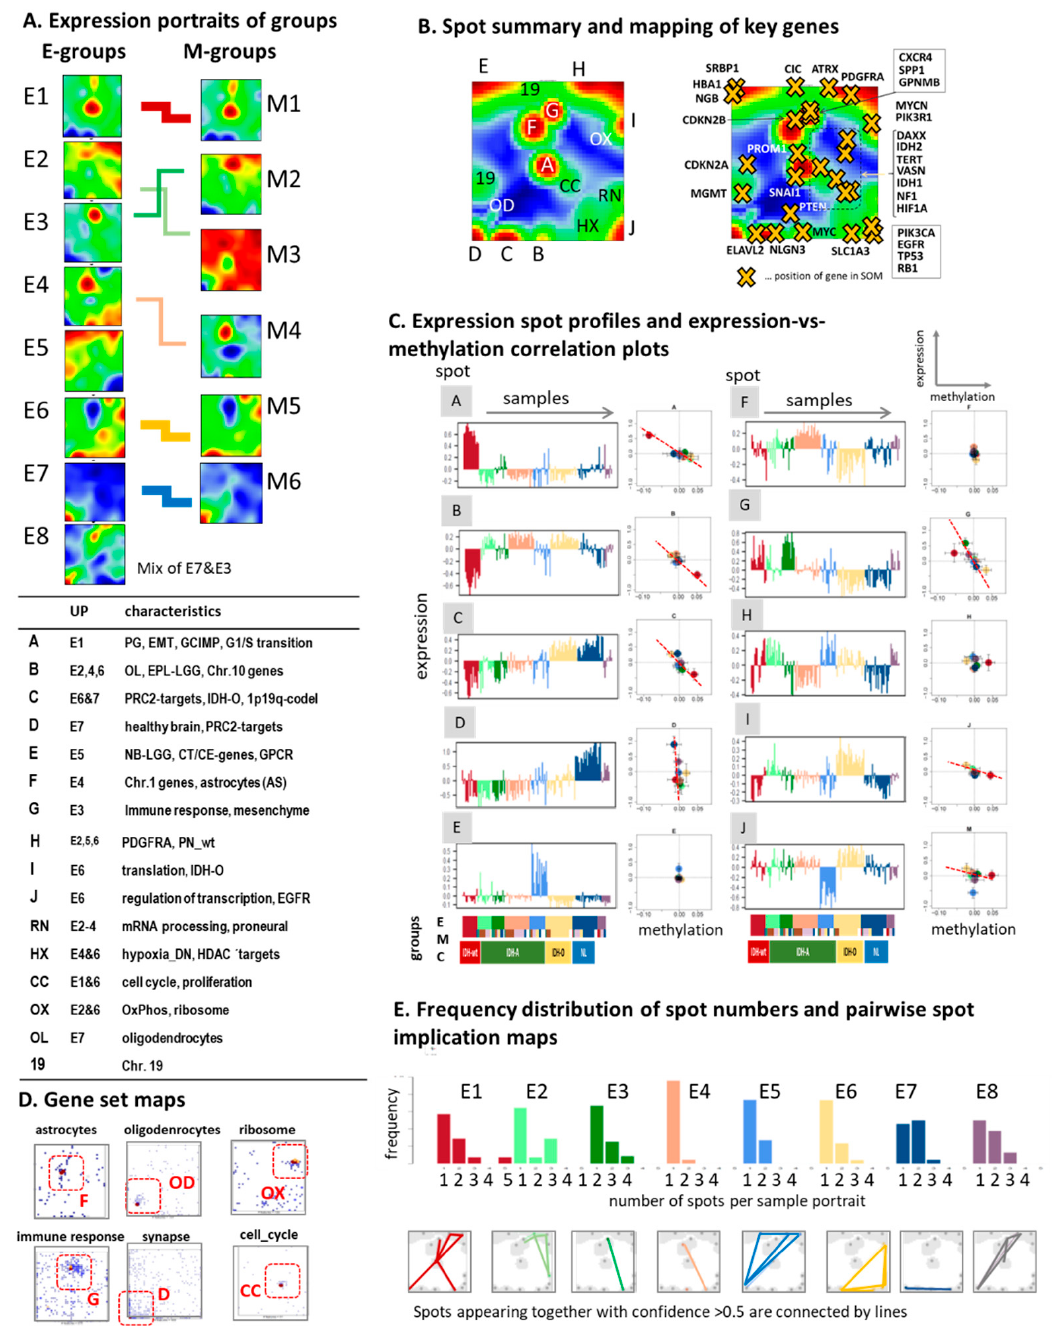
Figure 3. Cartography of the LGG transcriptome. ( A ) Mean SOM expression portraits of the E-groups were specific for each class and revealed correspondence with the expression portraits of the M-groups. ( B ) The LGG transcriptomes divide into 10 major modules of co-expressed genes with ( C ) characteristic profiles and mostly negative correlation between group averaged expression and gene promoter methylation (the scatter plots show mean expression versus mean methylation averaged over all genes included in the spot and all gliomas per group). ( D ) The gene set maps plot genes of selected functional context into the expression landscape. Please note their accumulation in different areas, which were assigned to the spots introduced above. ( E ) The spot-number distribution estimates the degree of the heterogeneity of sample portraits in terms of expressed spot modules and the spot implication maps join spots frequently appearing together (confidence > 0.5) in each of the subtypes by lines.